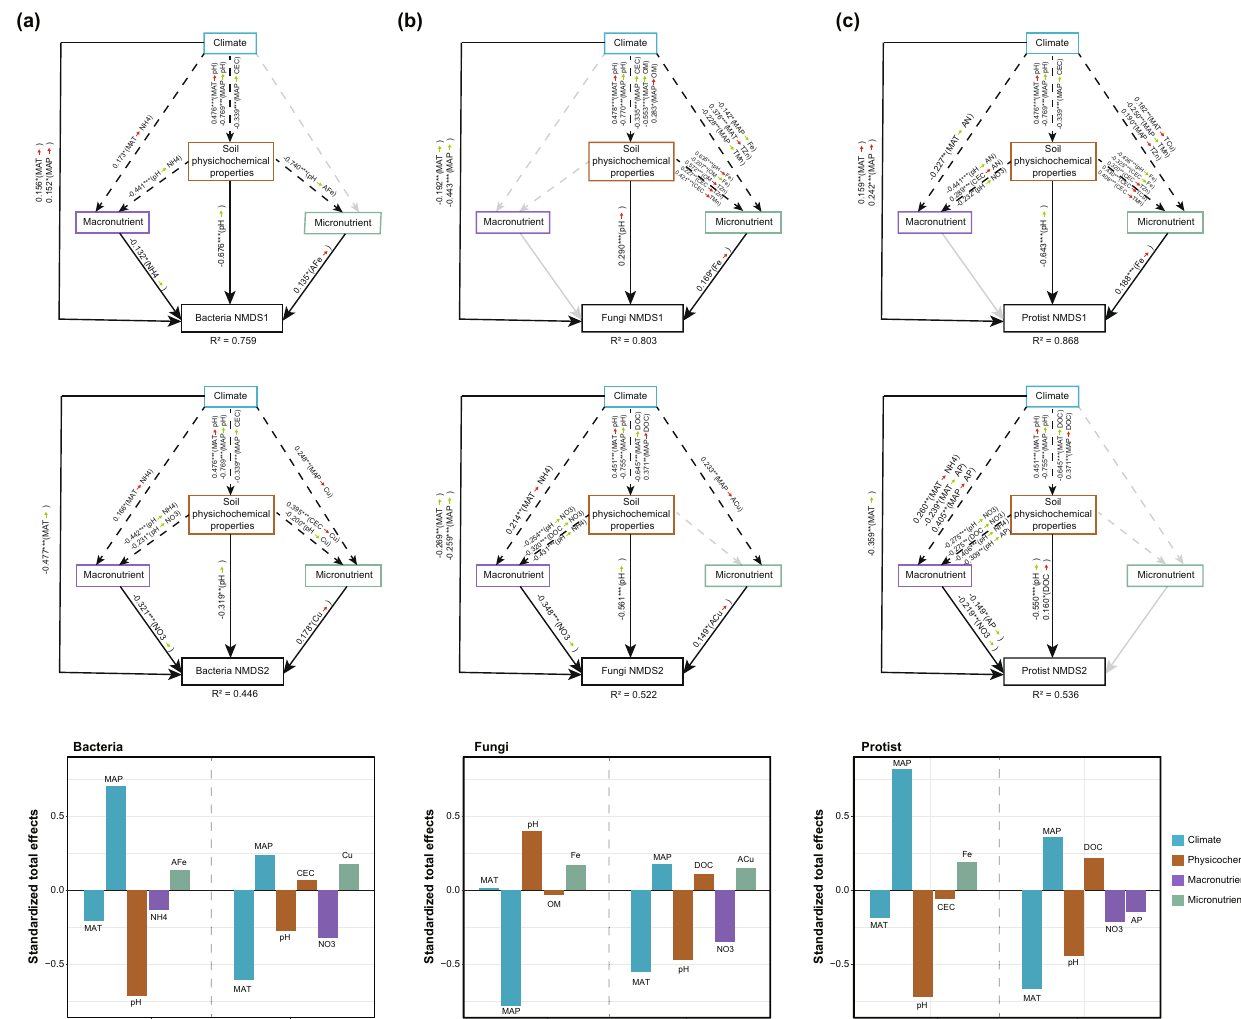
Fig. 3 Structural equation models identifying the direct (full lines) and indirect (dotted lines) in fl uence of different predictors on the structure of bacteria, fungi and protistan communities in maize soils. a bacteria, ( b ) fungi, ( c ), protist. Black lines indicate signi fi cant and numbers adjacent to lines were indicative of the effect size of the relationship. We grouped the climatic and edaphic properties into the same box in the model for graphical simplicity, which did not represent latent variables. R 2 denotes the proportion of variance explained. Red arrows represented positive paths, and green arrows represented negative paths. Signi fi cance levels were as follows: * p < 0.05, ** p < 0.01, and *** p < 0.001. The total standardized effects on SEM on the structure of microbial communities were calculated as sum of the direct and indirect effects. Information about our a priori model was provided in Supplementary Fig. 8. TZn total zinc, AZn available zinc, TFe total iron, AFe available iron, TCu total copper, ACu available copper, TMn total manganese, AMn available manganese, CEC cation exchange